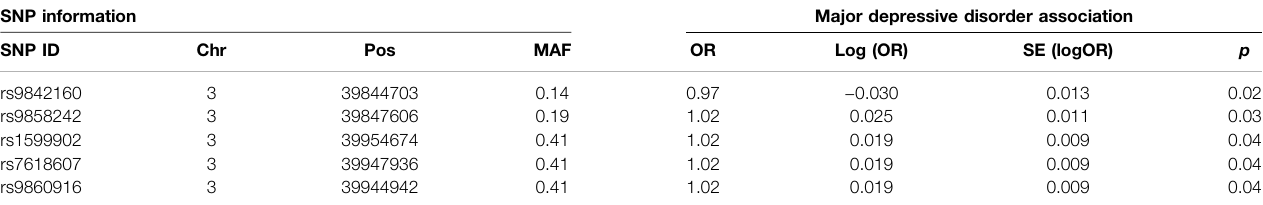
The columns are the SNP ID, chromosome, genome position of SNP, minor allele frequency, odds ratio, log of odds ratio, standard error of log odds ratio and association p -value.